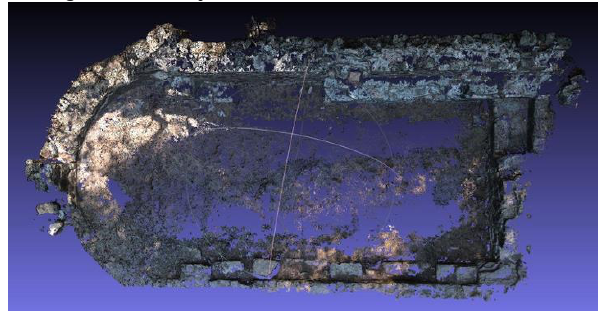
Figure 3. Dense cloud, St. Michel